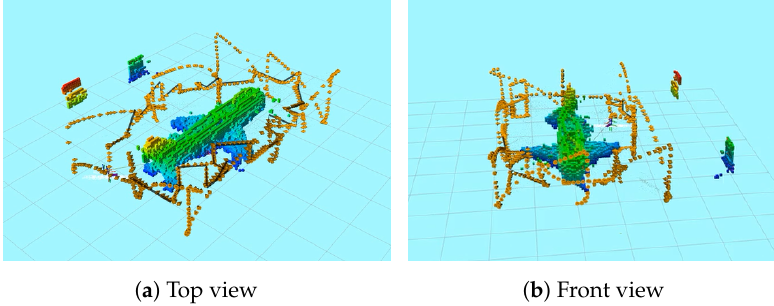
Figure 16. The path followed by the UAV shown in orange color including the profiling stage. The planned trajectory is shown in black and the reconstruction of the processed point cloud shown using OctoMap